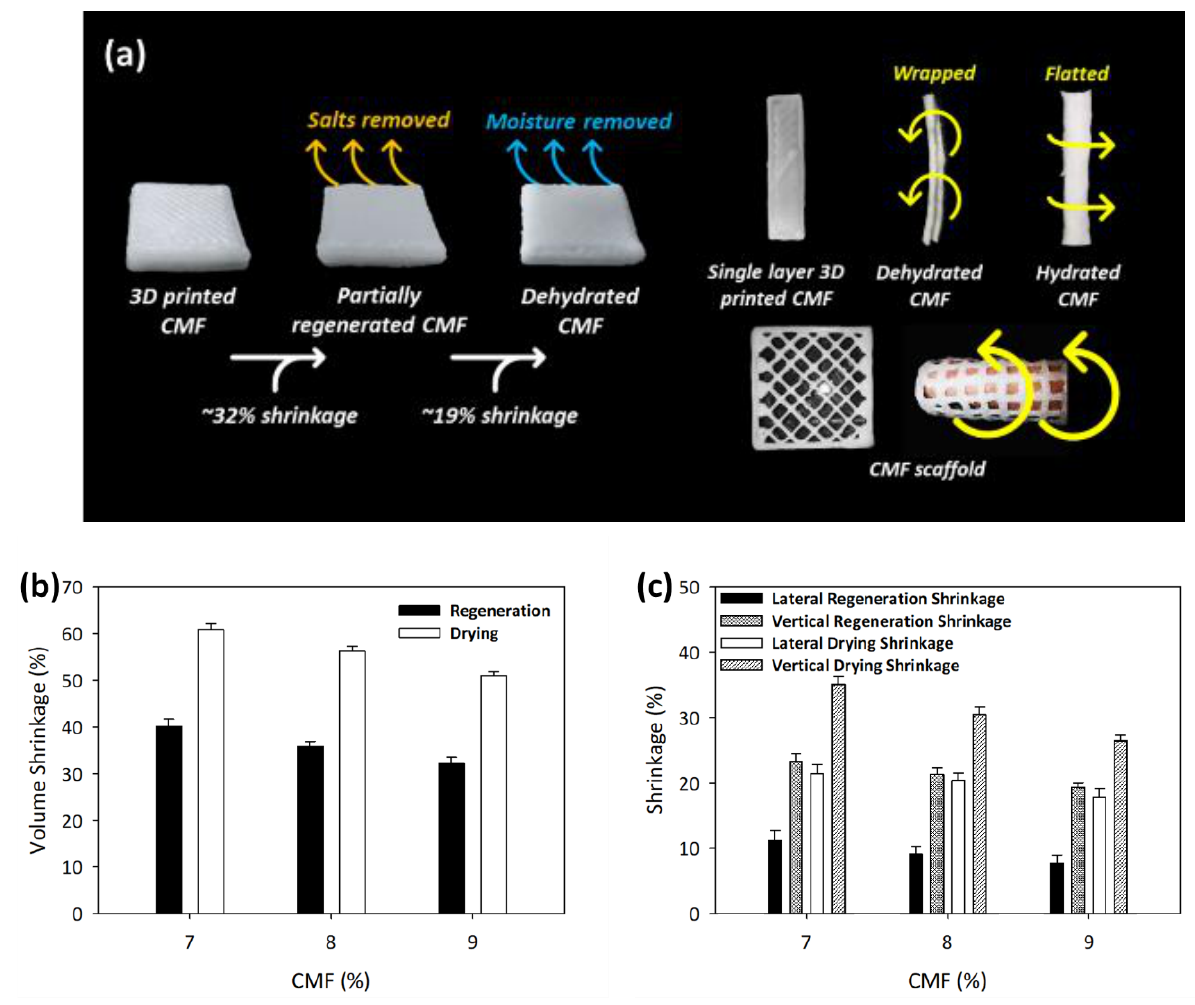
Figure 3. ( a ) Structural changes after dehydration–hydration process, ( b ) total volume, and ( c ) lateral/vertical shrinkages of printed CMFs. The data are presented as mean ± standard deviation (n = 3).